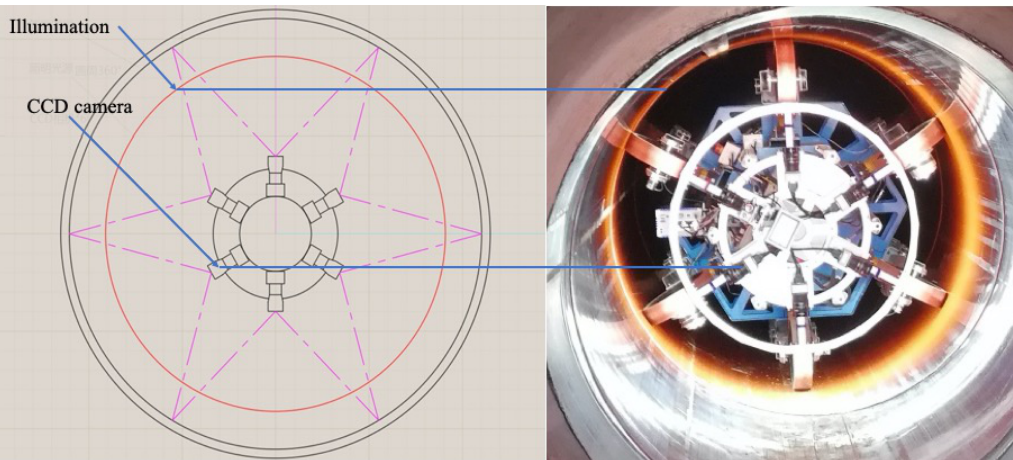
Figure 6. Layout of CCD cameras in inspection system. Note that the illumination indicates the projection of the light from the illuminator onto the wall of the